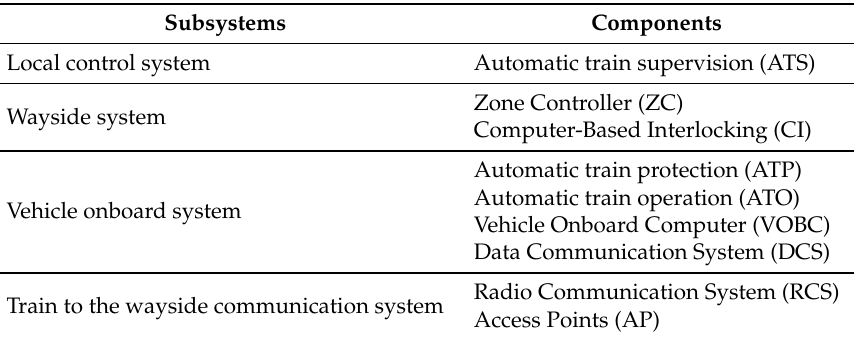
Table 10. System